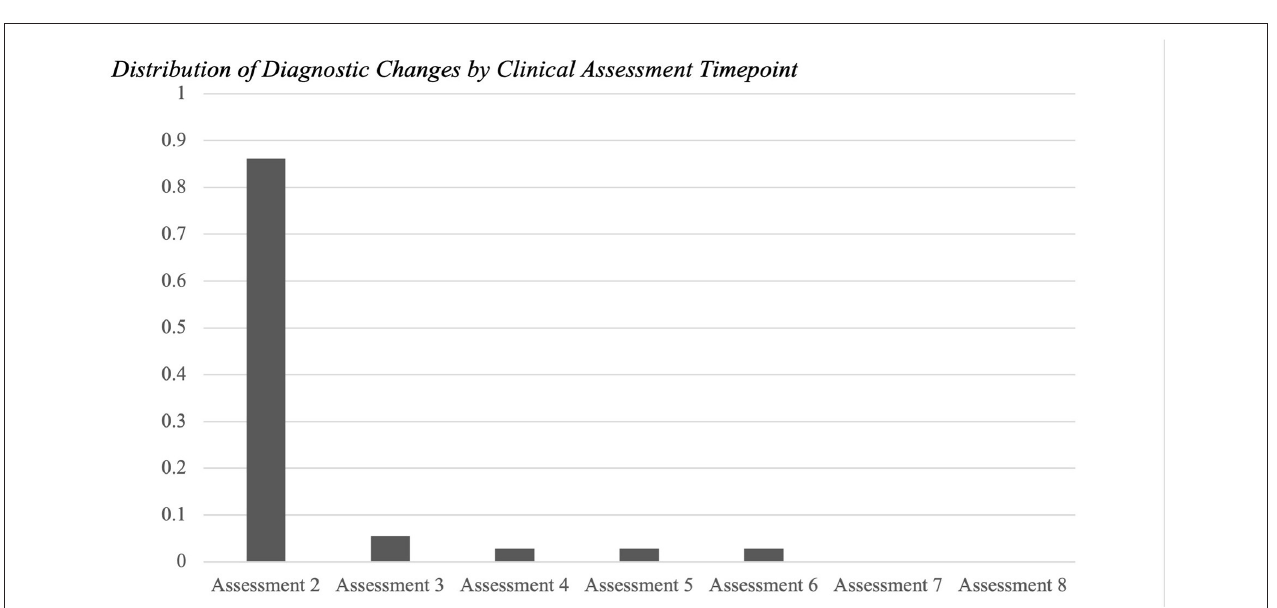
FIGURE 1 | Primary diagnosis at first and final clinical assessment. The distribution of primary psychotic disorder diagnoses at first clinical assessment and diagnoses at final clinical assessment. Diagnostic stability rates differed by psychotic disorders; in order from greatest to least: BP (86.9%), SZ (66.7%), SZA (63.6%), Psych NOS (33.3%), SZform